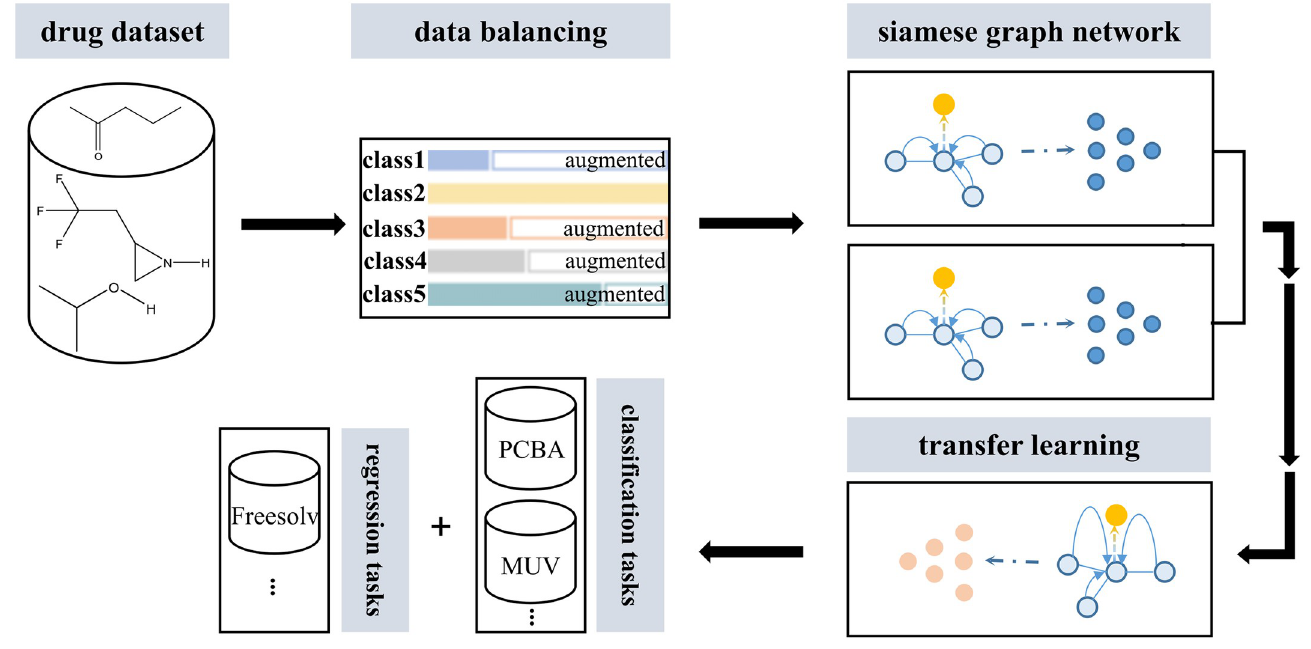
Fig 1. Summary of the Siamese graph convolutional network-based transfer learning workflow (SGT).